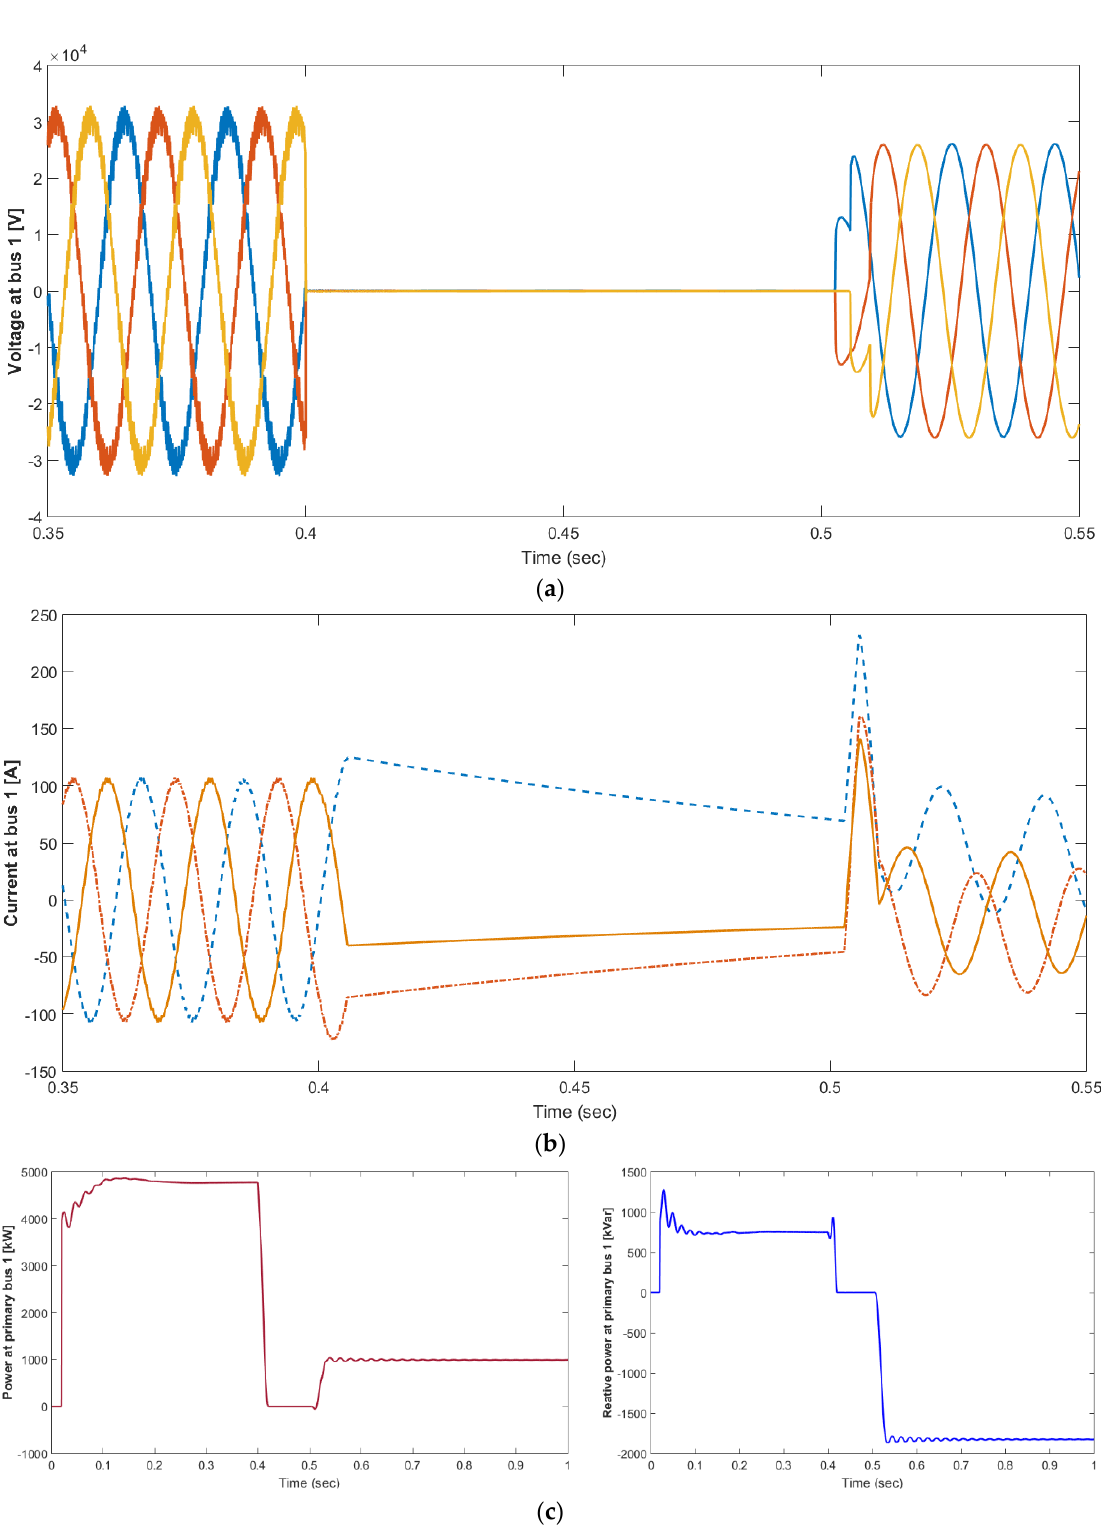
Figure 8. ( a ) Three-phase voltage at bus 1. ( b ). Three-phase current at bus 1. ( c ) Injected active power and ( b ) injected reactive power of one generator.